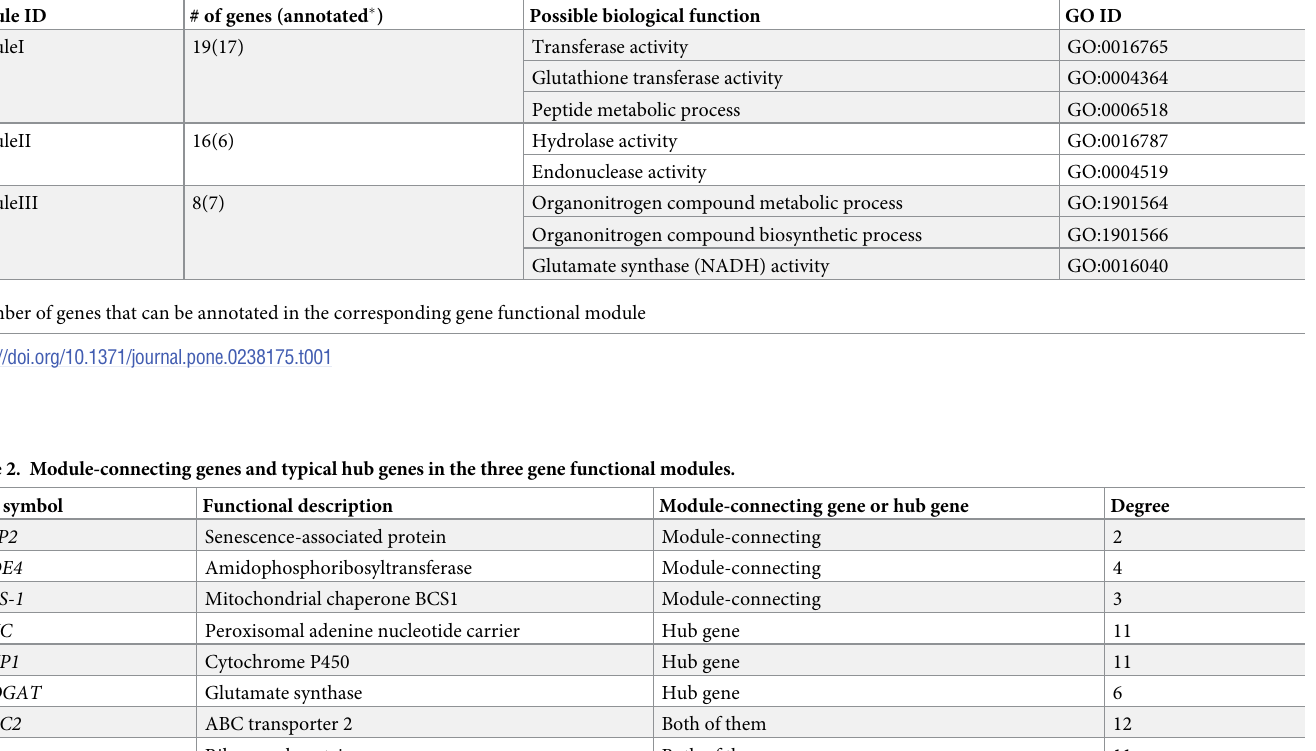
Table 1. GO functional enrichment analysis of the three gene functional modules ( p -value < 0.01). Module